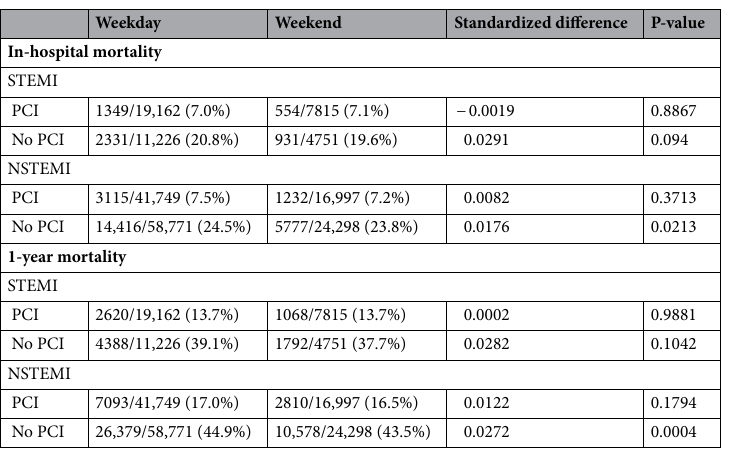
Table 2. In-hospital mortality and 1-year mortality according to admission time, stratified by subtype of myocardial infarction and percutaneous coronary intervention. NSTEMI non-ST elevation myocardial infarction, PCI percutaneous coronary intervention, STEMI ST elevation myocardial infarction.